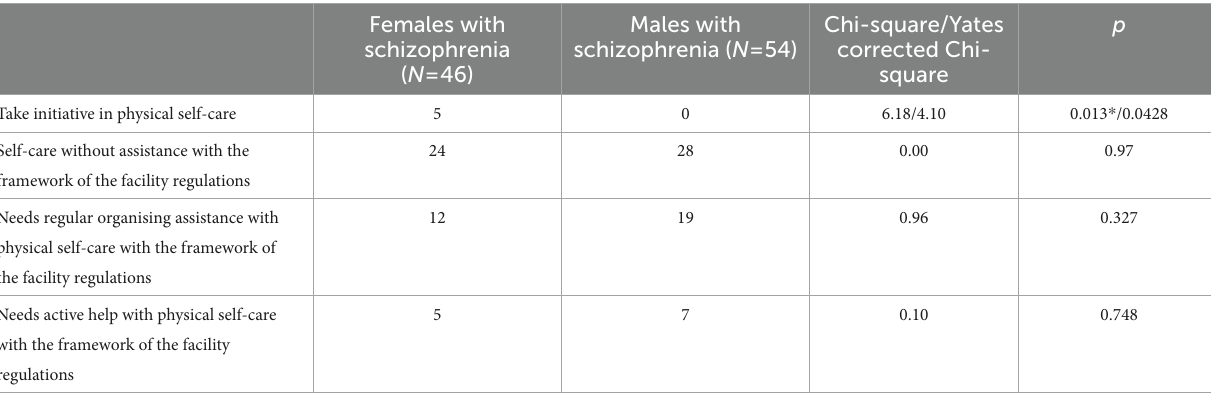
Females with schizophrenia